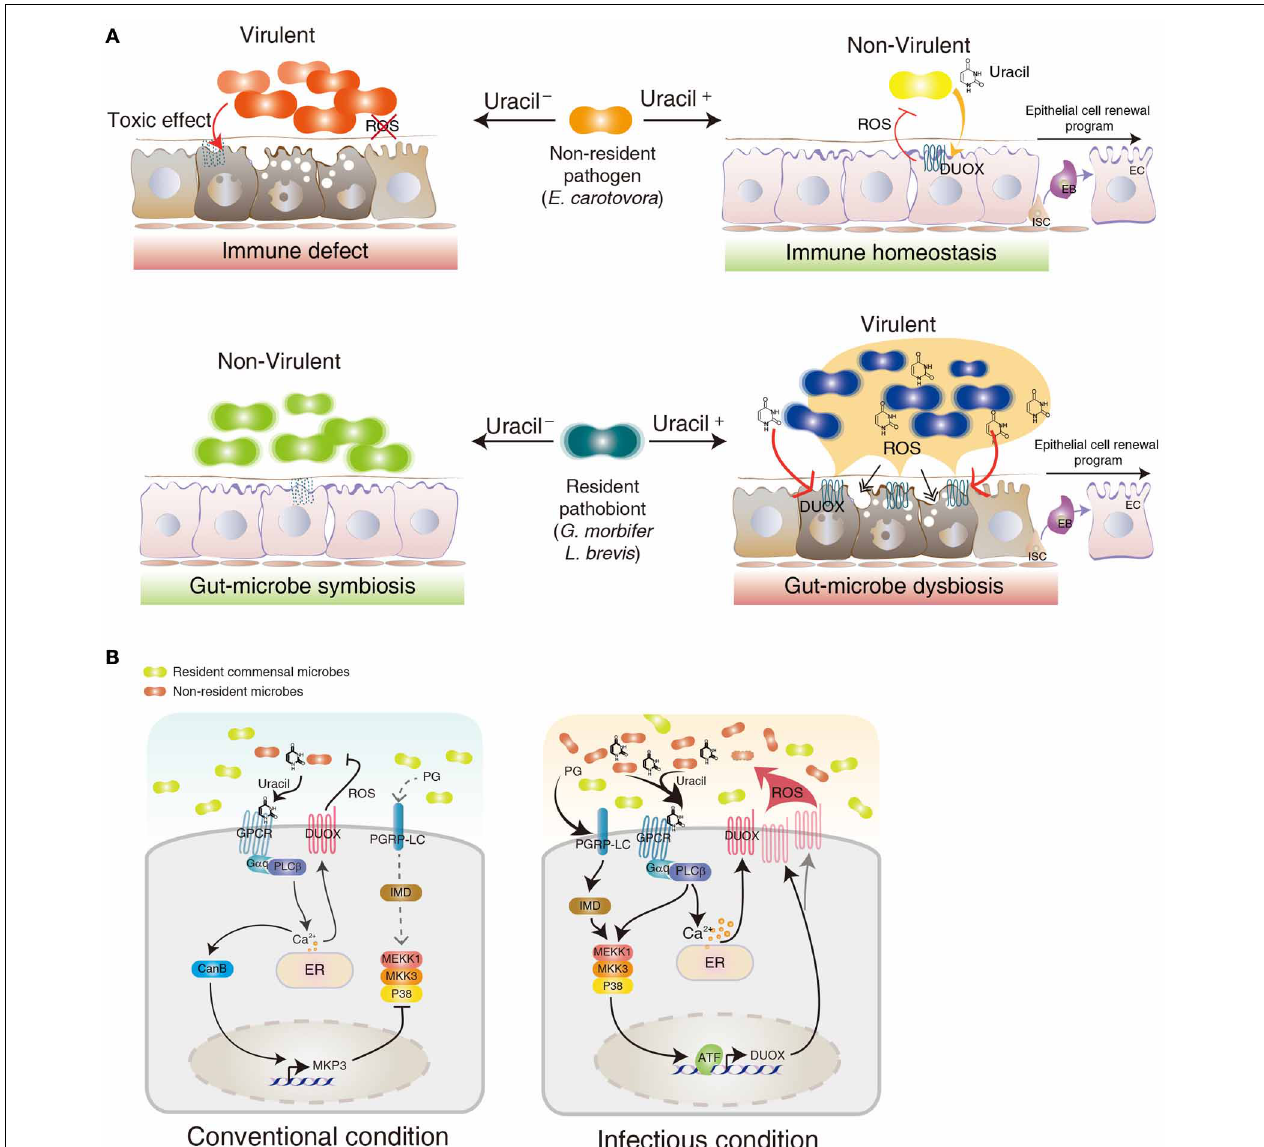
FIGURE 2 | Role of DUOX in gut-microbe interactions. (A) Different gut physiologies depending different uracil-releasing states (Uracil − and Uracil + for uracil non-releasing and releasing state, respectively) and different